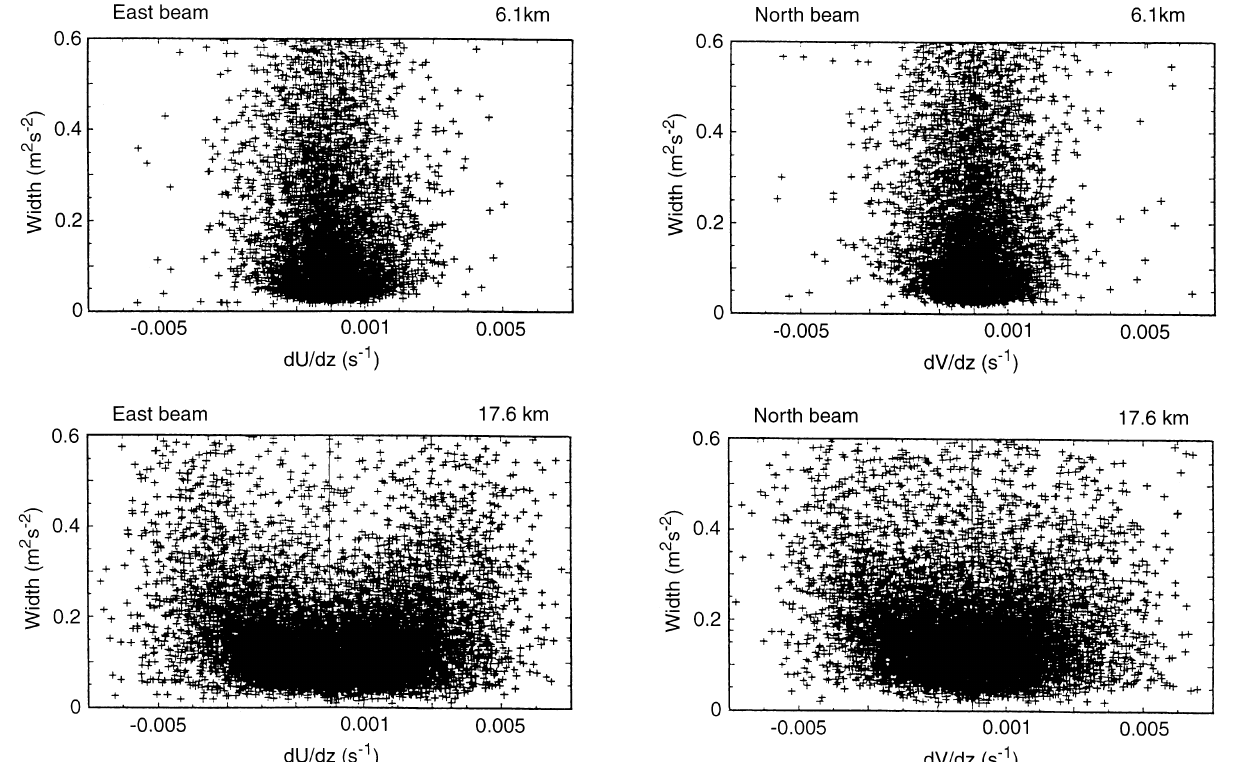
Fig. 7. Hourly means of the Doppler spectral widths observed at WSMR at 6.1 and 17 : 6km as a function of the observed vertical shear of the horizontal